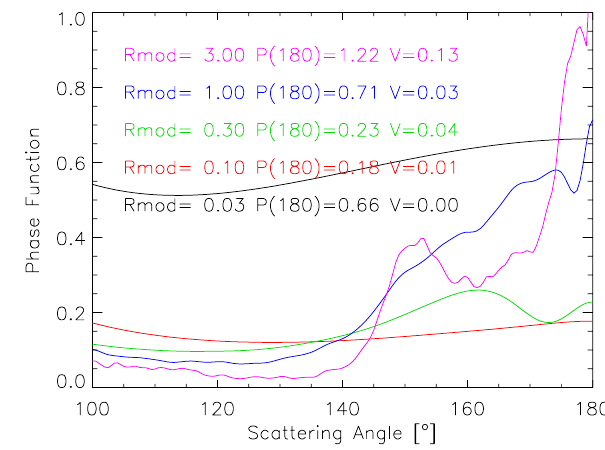
Fig. 3. Results of Mie simulations for a log-normal size distribution of width 0.4 and various values of the modal radius (expressed in µm). For these simulations, the wavelength is 0.6 µm and the refrac- tive index is 1.4. The slope at backscatter has been computed over the [173–180] ◦ range as it is similar to POLDER angular